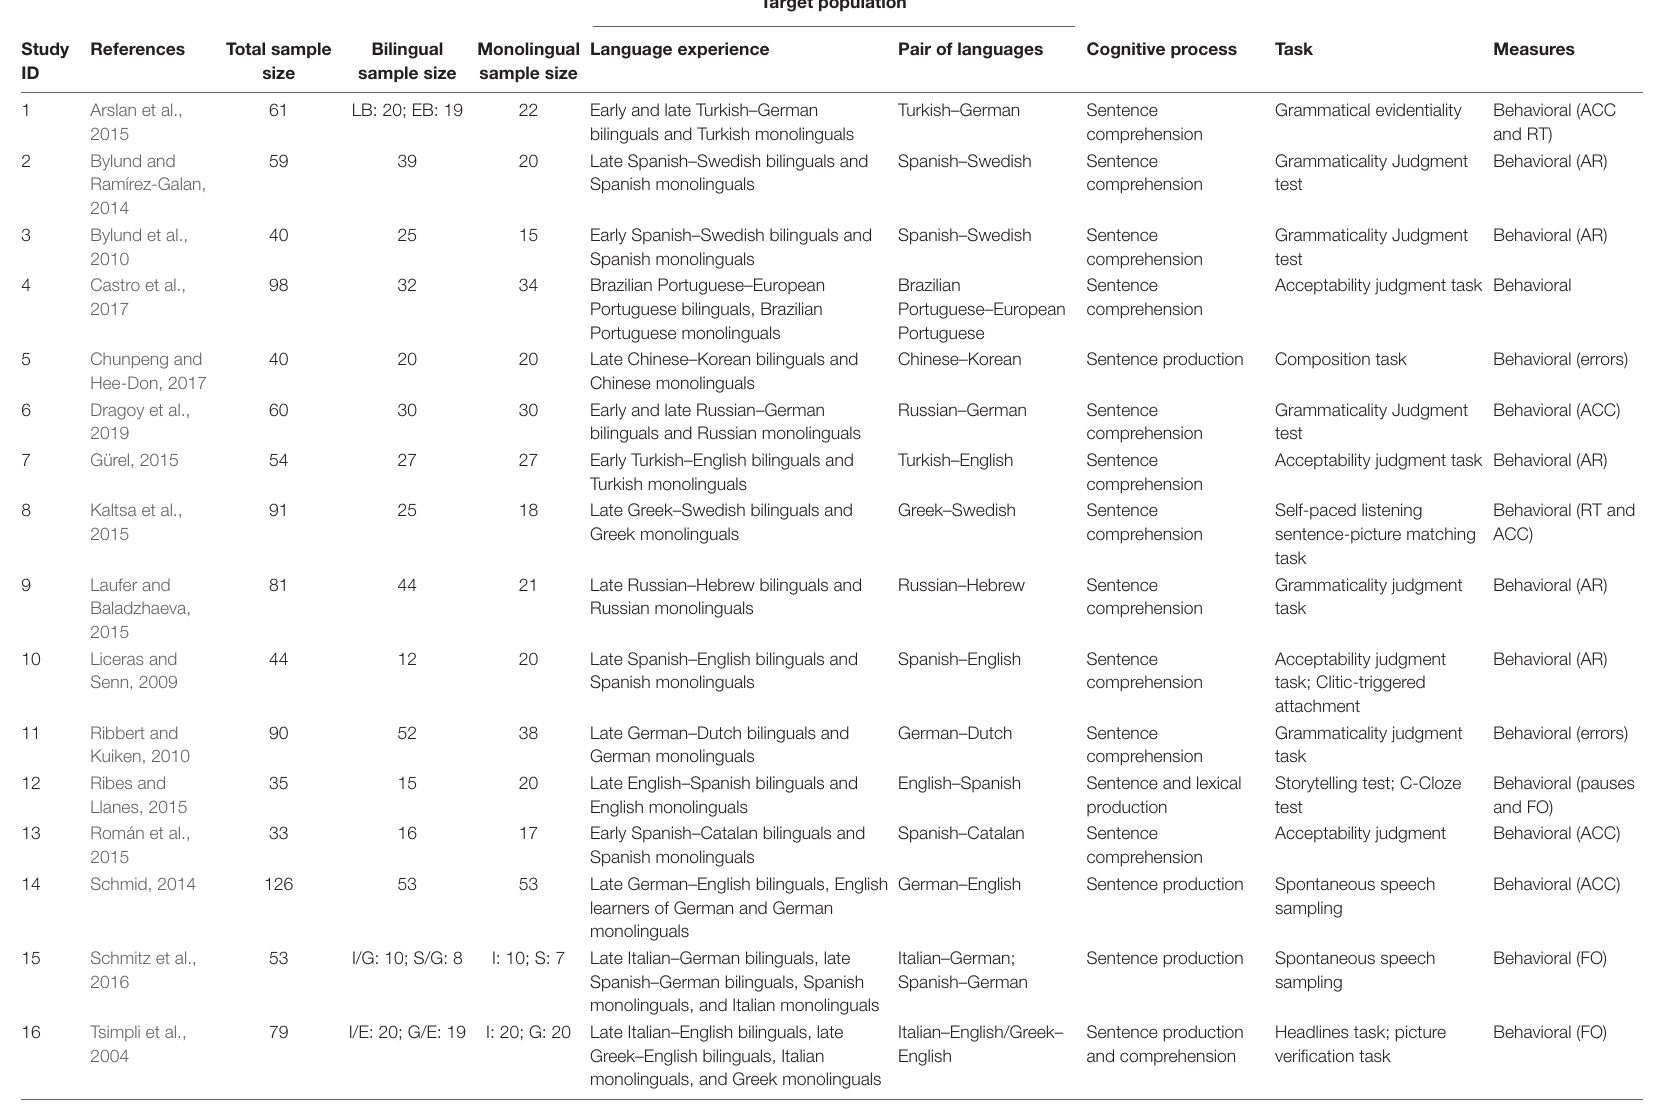
TABLE 1 | Characteristics of the studies included in the systematic